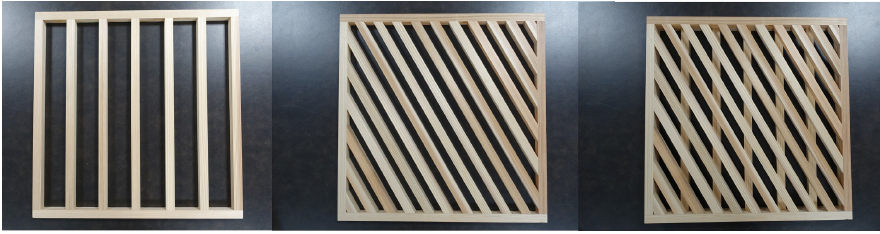
Figure 2. Manufactured samples: R-1 ( Left ); R-2 ( Center ); and crossed rib diffuser ( Right